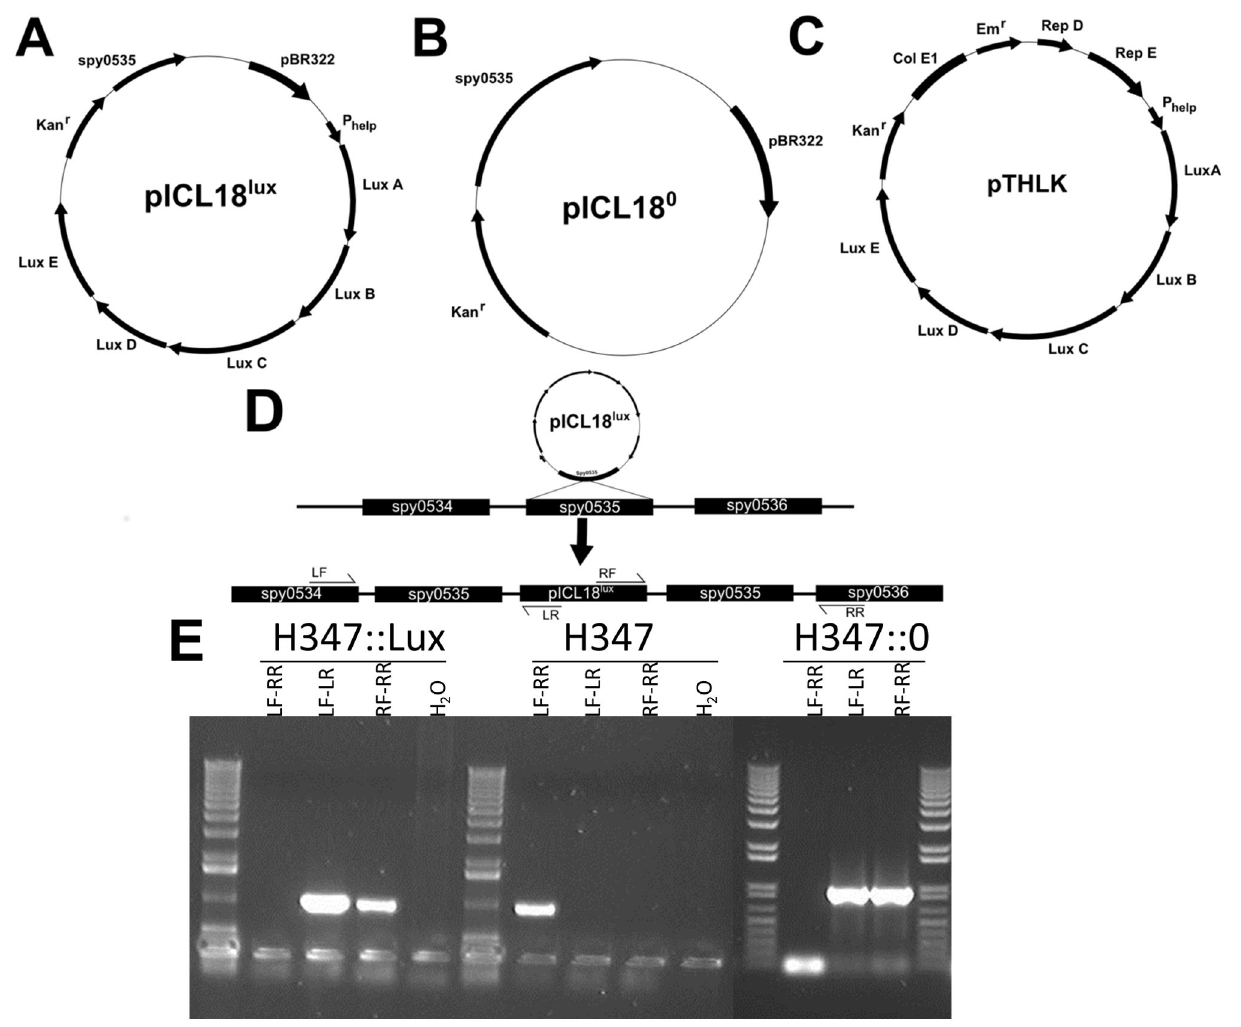
Figure 1. Plasmids and integration of pICL18lux into the S. pyogenes chromosome. The integrating plasmids pICL18 lux (A) and pICL18 0 (B) and the replicating plasmid construct pTHLK (C) are demonstrated, with arrows indicating locations and orientations of open reading frames. A diagrammatic representation of the integration of the plasmid pICL18 lux into the S. pyogenes chromosome via a single crossover is shown with the targets for the diagnostic primers LF, LR, RF and RR. Integration will produce positive results for the regions between LF-LR and RF-RR (D). PCR using these primers was performed on DNA purified from H347::lux, H347 and the H347::0 (E) and confirmed integration of pICL18 lux and pICL18 0 into the S. pyogenes genome at the Spy0535 locus. doi: 10.1371/journal.pone.0082123.g001 Animals Female 4-5 week old FVB/n mice (Harlan, UK) were maintained in individually HEPA filtered cages with sterile bedding and free access to sterilized food and water. GLP Mini Fun Tunnels (Lillico) were provided in each cage for environmental enrichment. Mice were weighed daily; reduction by 20% of original weight was a defined humane endpoint.